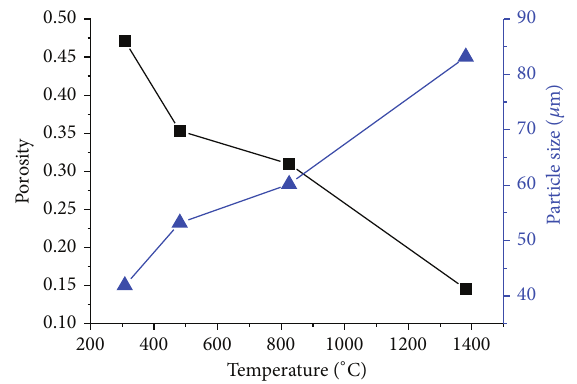
Figure 7: Mean particle size and porosity at different